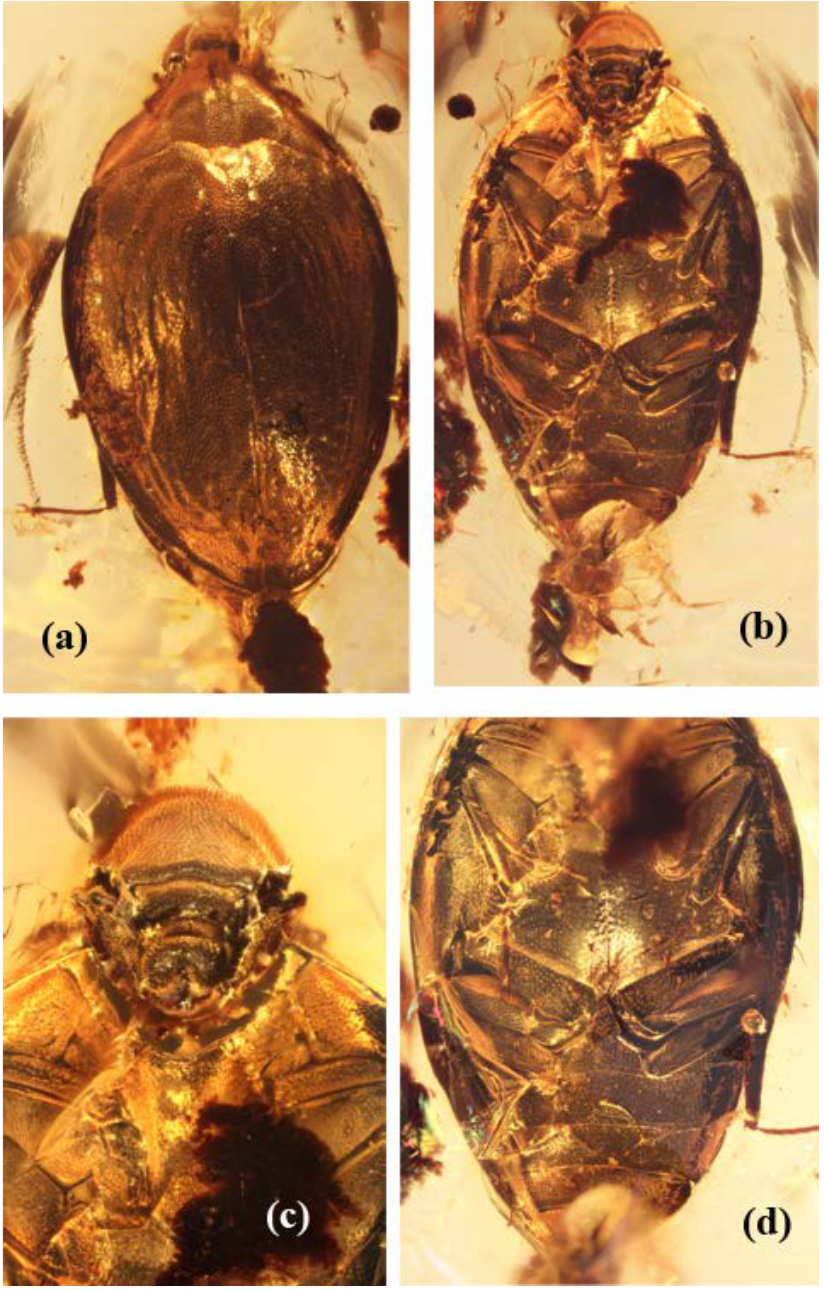
Figure 1. Burmochares groehni Kirejtshuk et Prokin, gen. et sp. nov. , holotype (GPIH no. 5071, CCGG no. 20037, LIBH): ( a ) habitus, dorsal view; ( b ) habitus, ventral view; ( c ) anterior part of body, ventral view; ( d ) posterior part of body, ventral view. Body length 2.85 mm.